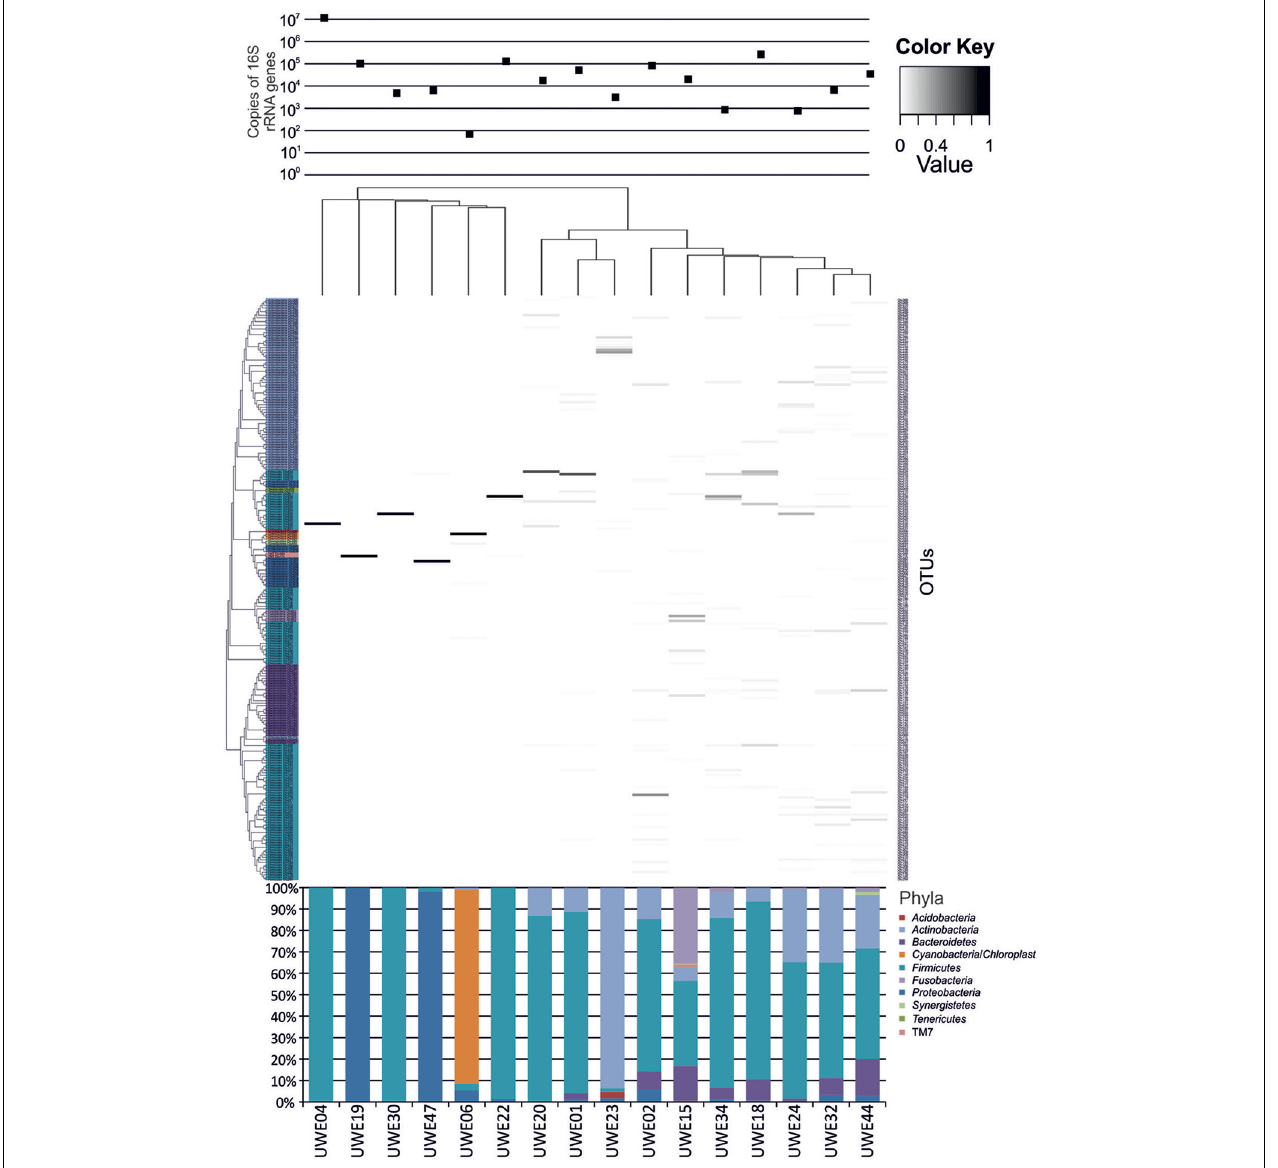
FIGURE 1 | Heatmap showing the relative abundance of the OTUs per sample. The top panel presents the qPCR values for each sample while the bottom panel shows the percentage distribution of the OTUs’ phyla for each